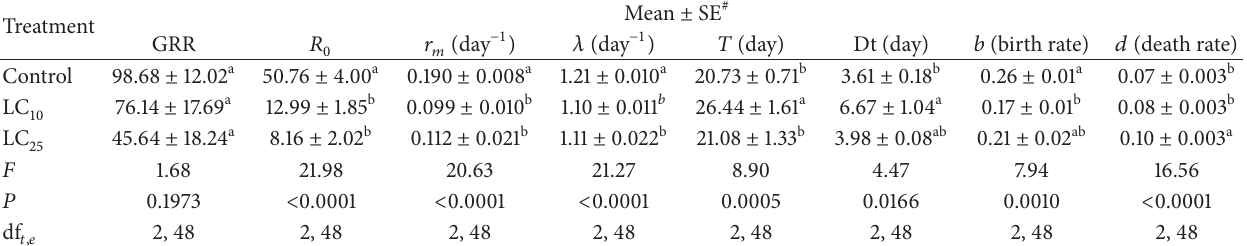
Table 5: The effects of pyriproxyfen on the biological parameters of 3rd instar larvae of P. xylostella in the next generation. Treatment